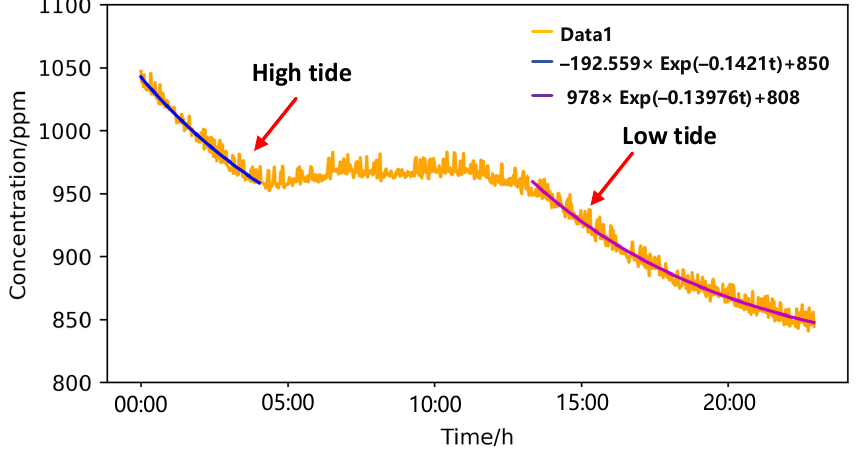
Figure 11. The result of In-situ measurements near coast.